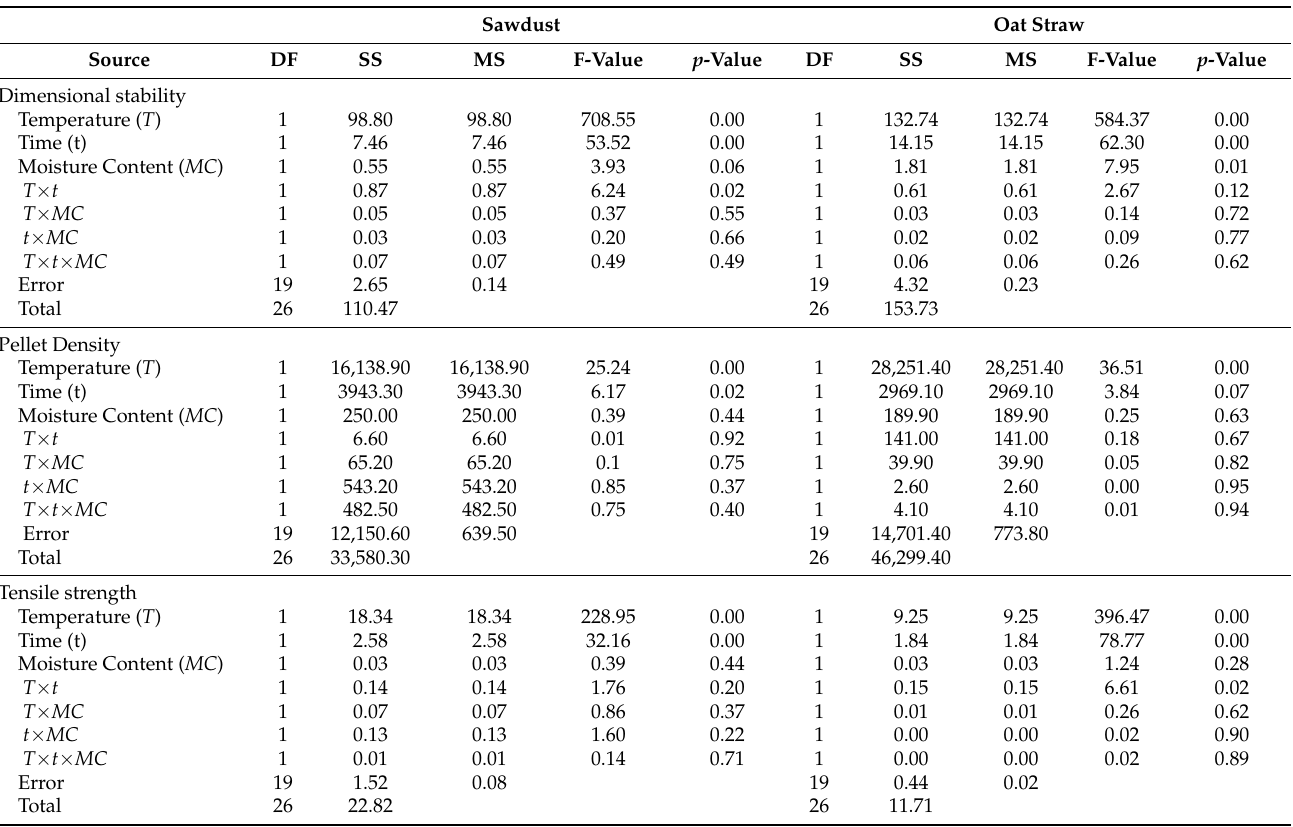
Table 3. Analysis of variance (ANOVA) table for factors affecting dimensional stability, pellet density, and tensile strength of biomass